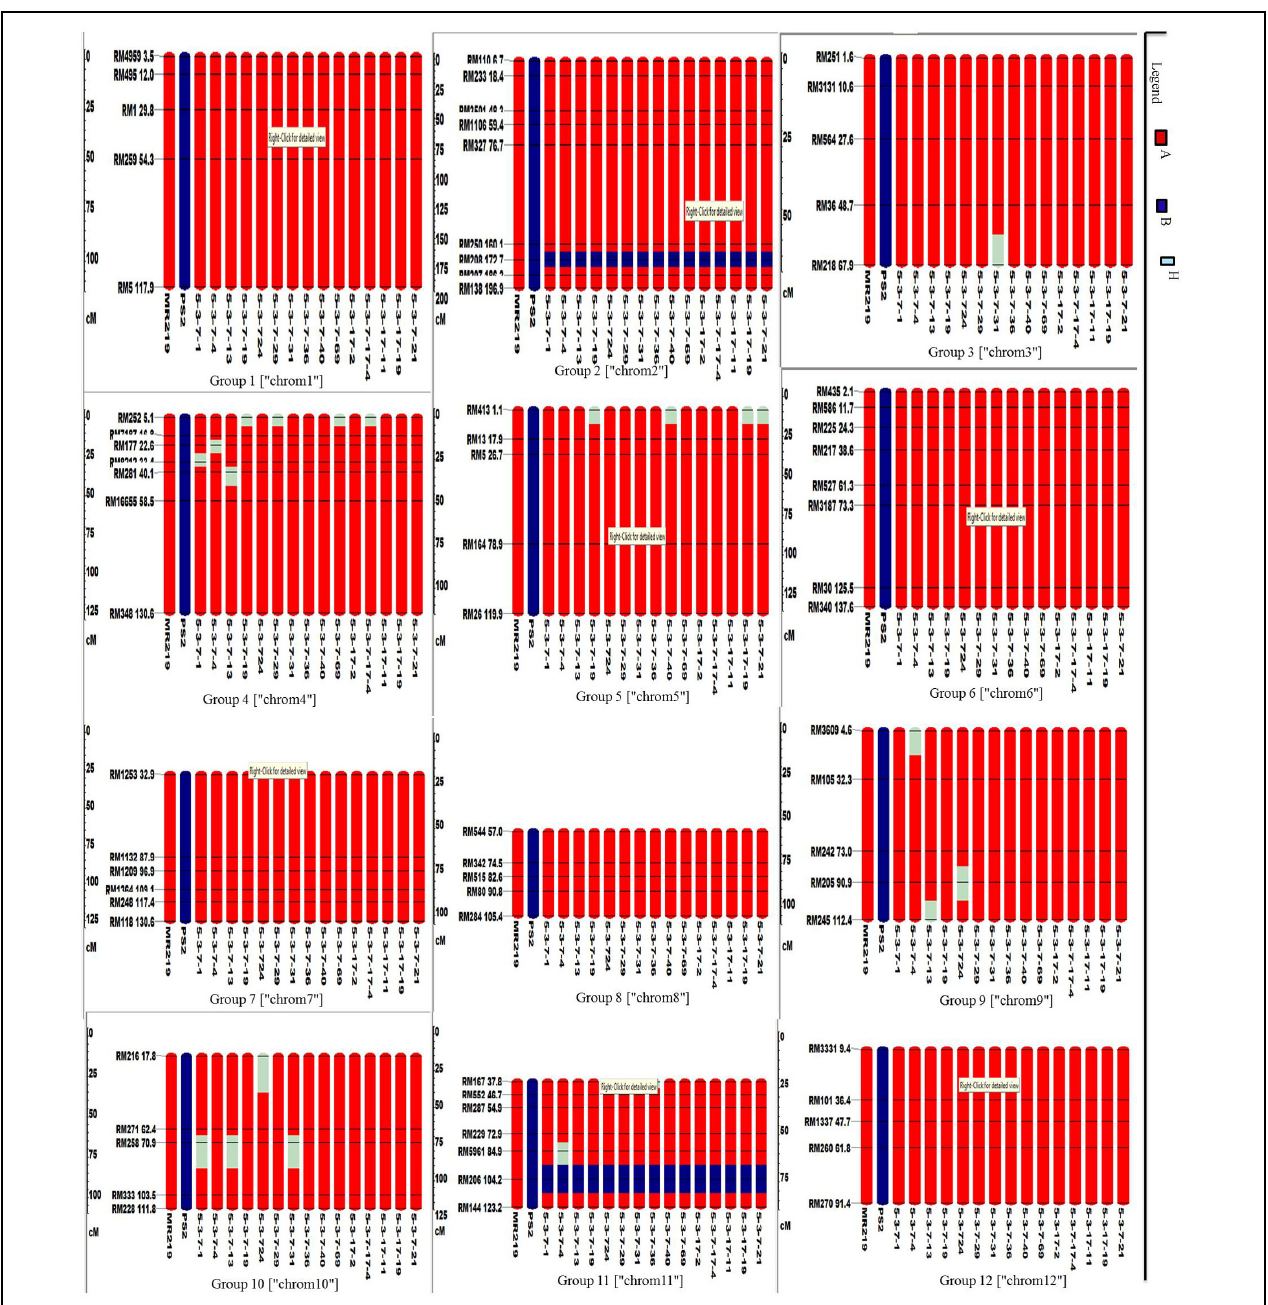
FIGURE 4 | Graphical genotyping of selected 15 improved lines with introgressed Pi genes along with MR219 background developed in this study. The red color indicates homozygous regions for MR219, the blue color indicates homozygous regions for Pongsu Seribu 2 and the light green color indicates heterozygous